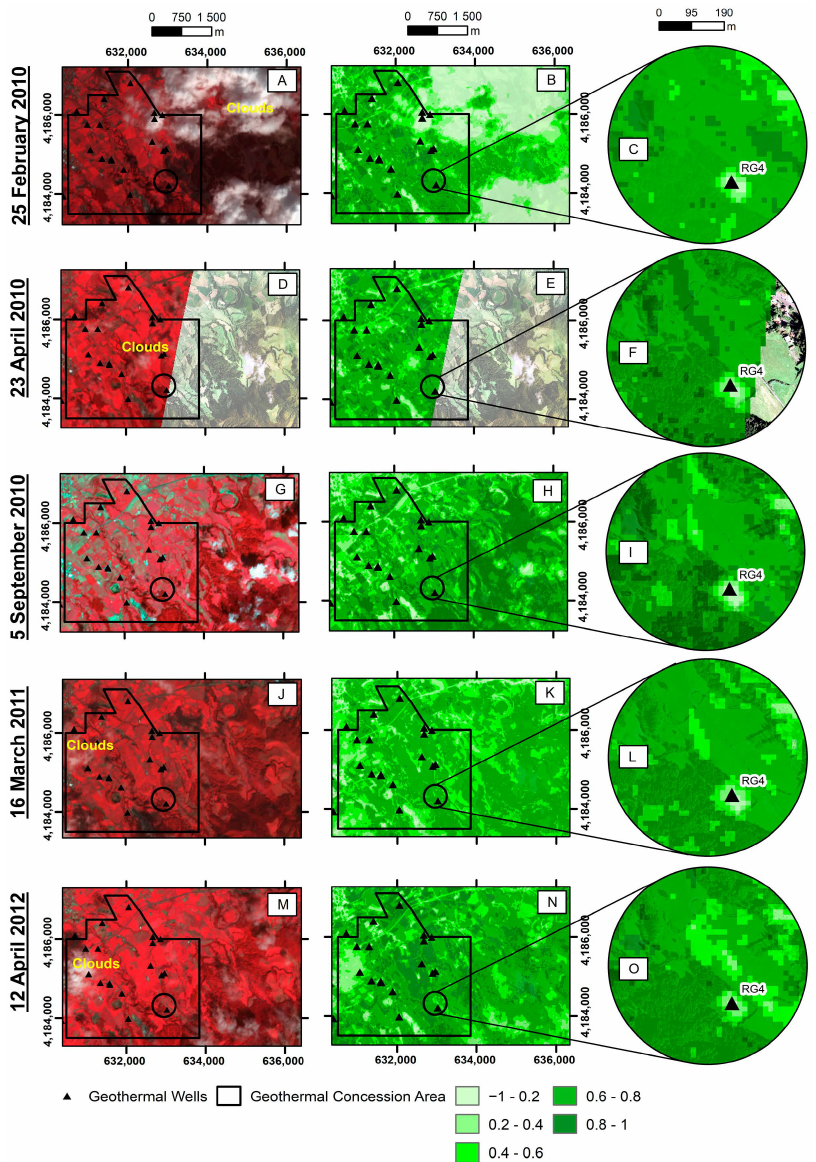
Figure 7. Part of the northern flank of Fogo Volcano: the ASTER RGB composite image (bands 3, 2, 1), the NDVI map of the study area, and framing of the NDVI map near the RG4 well, respectively, for the following dates: 25 February 2010 ( A , B , C ); 23 April 2010 ( D , E , F ); 5 September 2010 ( G , H , I ); 16 March 2011 ( J , K , L ); 12 April 2012 ( M , N , O ). In September 2010, at the end of the summer season (a period with lower rainfall), there was a significant increase in areas with low NDVI values around the RG4